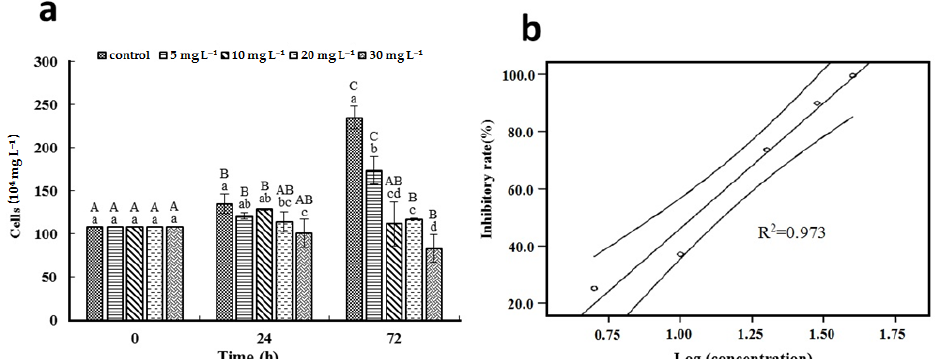
Figure 1. Effect of [Hmim]Cl on M. aeruginosa PCC 7806 growth. ( a ) Cell density after 24 h and 72 h of incubation. ( b ) Regression analysis between [Hmim]Cl concentration and inhibitory rate after 72 h. Average values ± standard deviation ( n = 3). Different uppercase letters represent significant differences ( p < 0.05) between exposure times within the same treatment. Different lowercase letters represent significant differences ( p < 0.05) between treatments within the same exposure time.